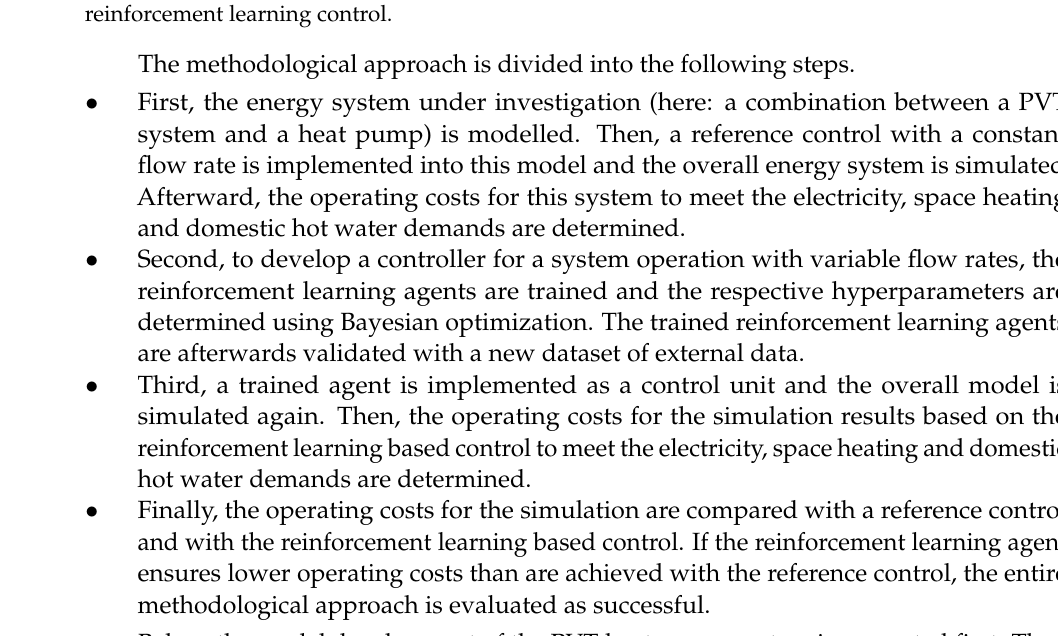
Figure 1. Methodological approach to compare operating costs between a reference control and a reinforcement learning control.